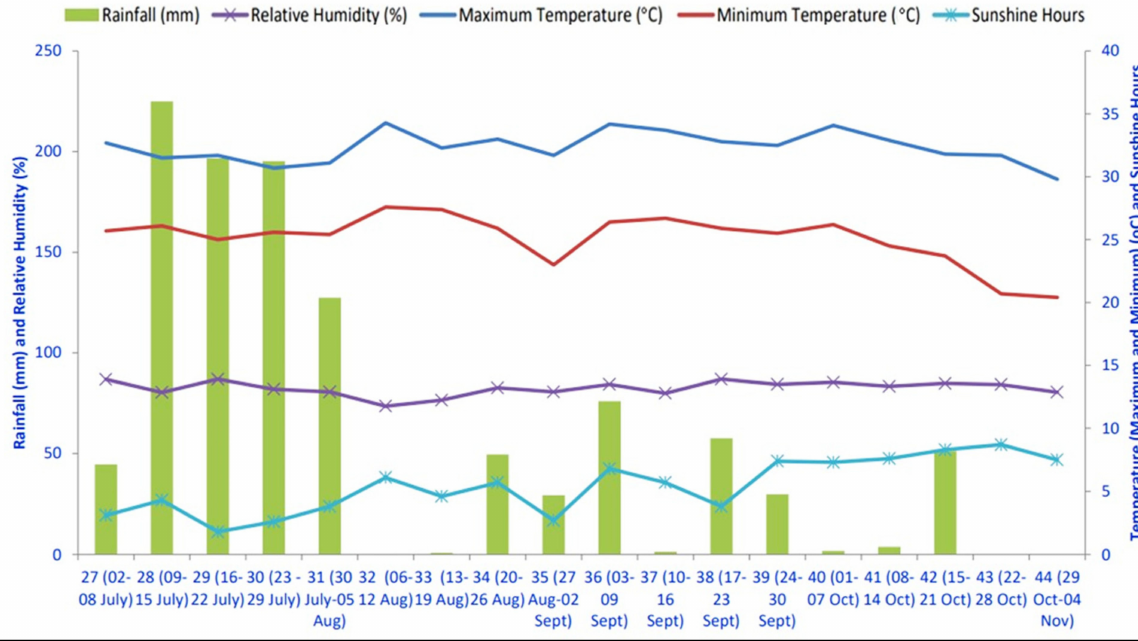
T 1 : aerobic culture., T 2 : SRI., T 3 : conventional flooded transplanted rice (CTR) culture were taken in main plots and eight nutrient management treatments, namely, F 1 : absolute control, F 2 : 100% recommended dose of fertilizers (RDF) through the chemical form (80 kg N ha − 1